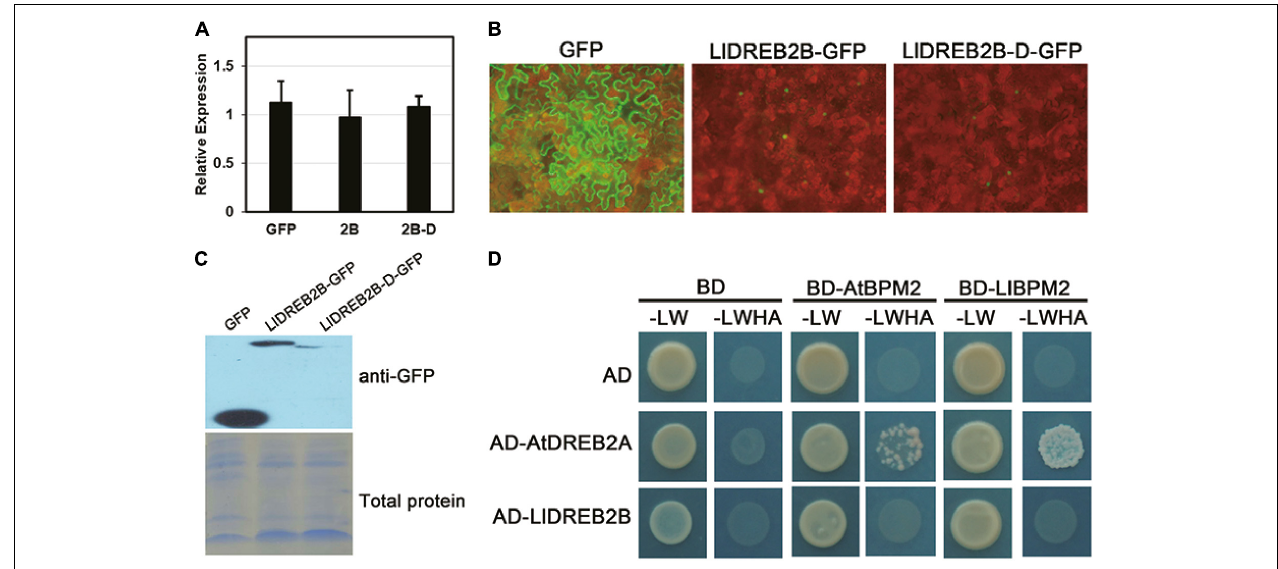
FIGURE 6 | Analysis of the predicted NRD regulation of LlDREB2B. (A) Determination of transcript level after transient expression. Premiers targeting GFP were used for expression detection. Tobacco Nt Ubiquitin was used for data normalization. Bars are means ± SD of three biological repeats. (B) Fluorescence signals of GFP, LlDREB2B-GFP, and LlDREB2B-D-GFP. (C) Western blot assay of protein accumulation in tobacco leaves with transient expression. (D) Interaction of LlDREB2B or AtDREB2A with LlBPM2 and AtBPM2 determined by yeast cell growth on SD medium lacking Leu, Trp, His, and Ade (SD-LW